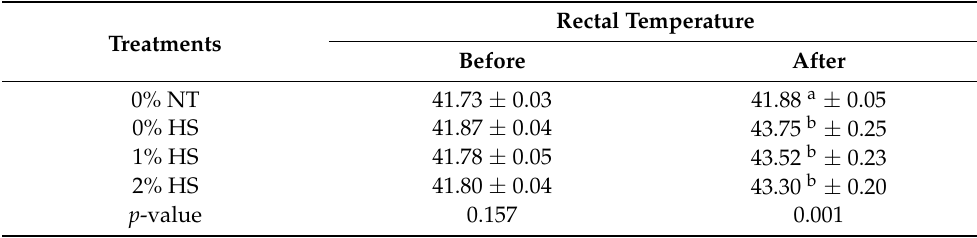
Table 2. Effects of dietary steam-exploded pine particles supplementation on the rectal temperature of thermoneutral and heat-stressed broiler chickens.